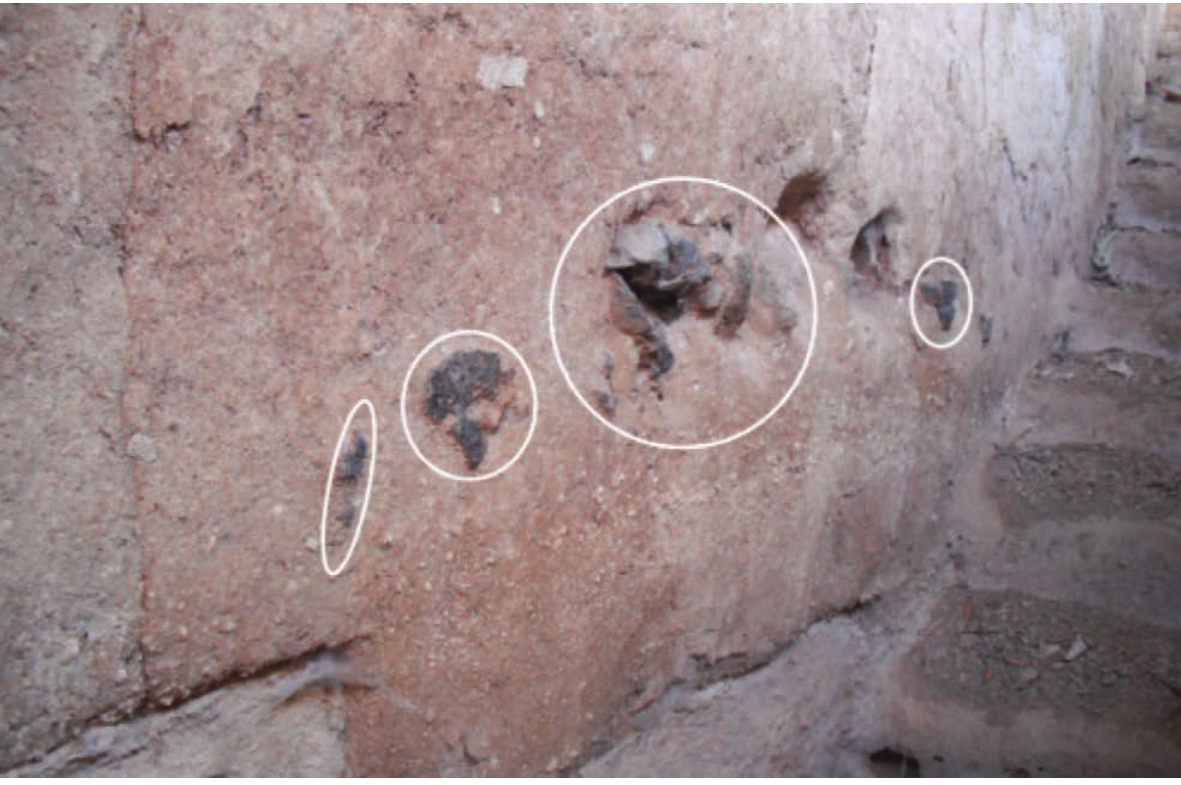
Figure 4. Tephra lithics scattered in Sorano unit 2